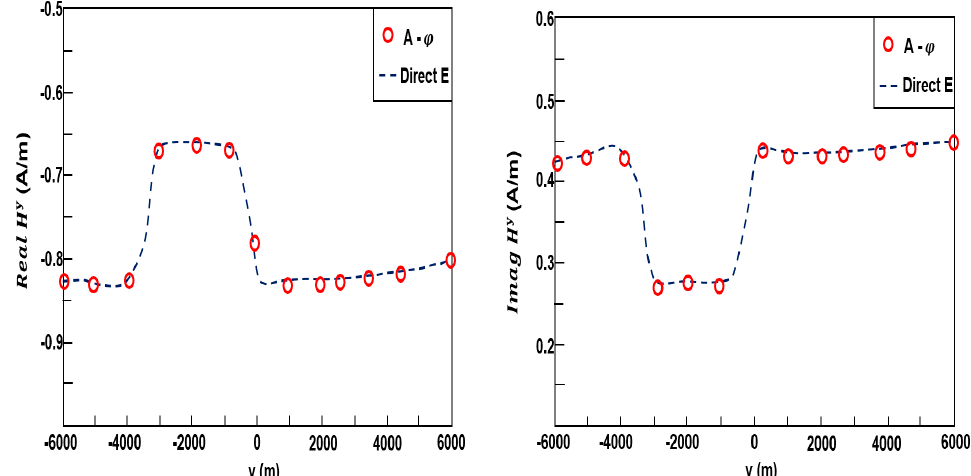
Figure 6. The plot of the H y for the E x polarization (real and imaginary) calculated using the Potential and Direct E formulation.